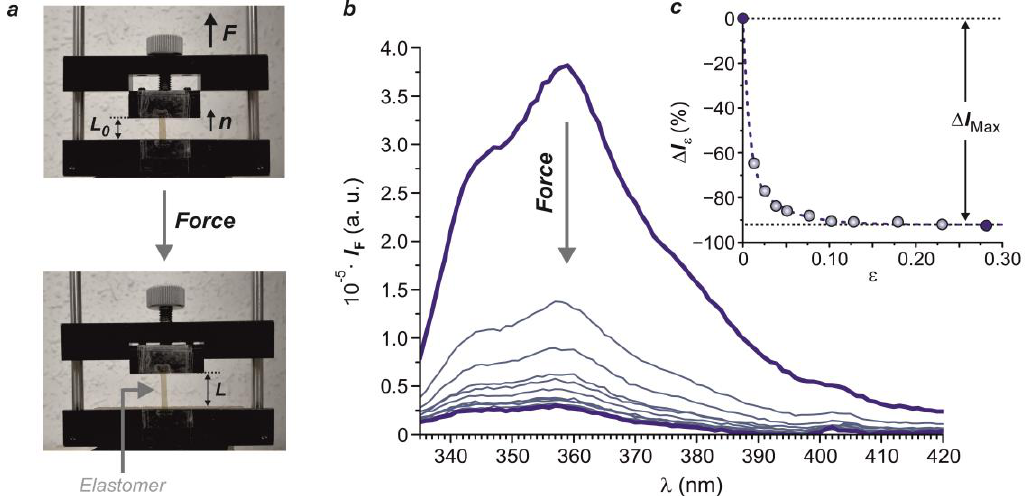
Figure 1. ( a ) Deformation of an LSCE along the direction director, ( b ) evolution of the emission spectrum, and ( c ) variation of the relative emission intensity, ∆ I ε , of a representative LSCE upon applying a uniaxial deformation ε along its anisotropic direction.